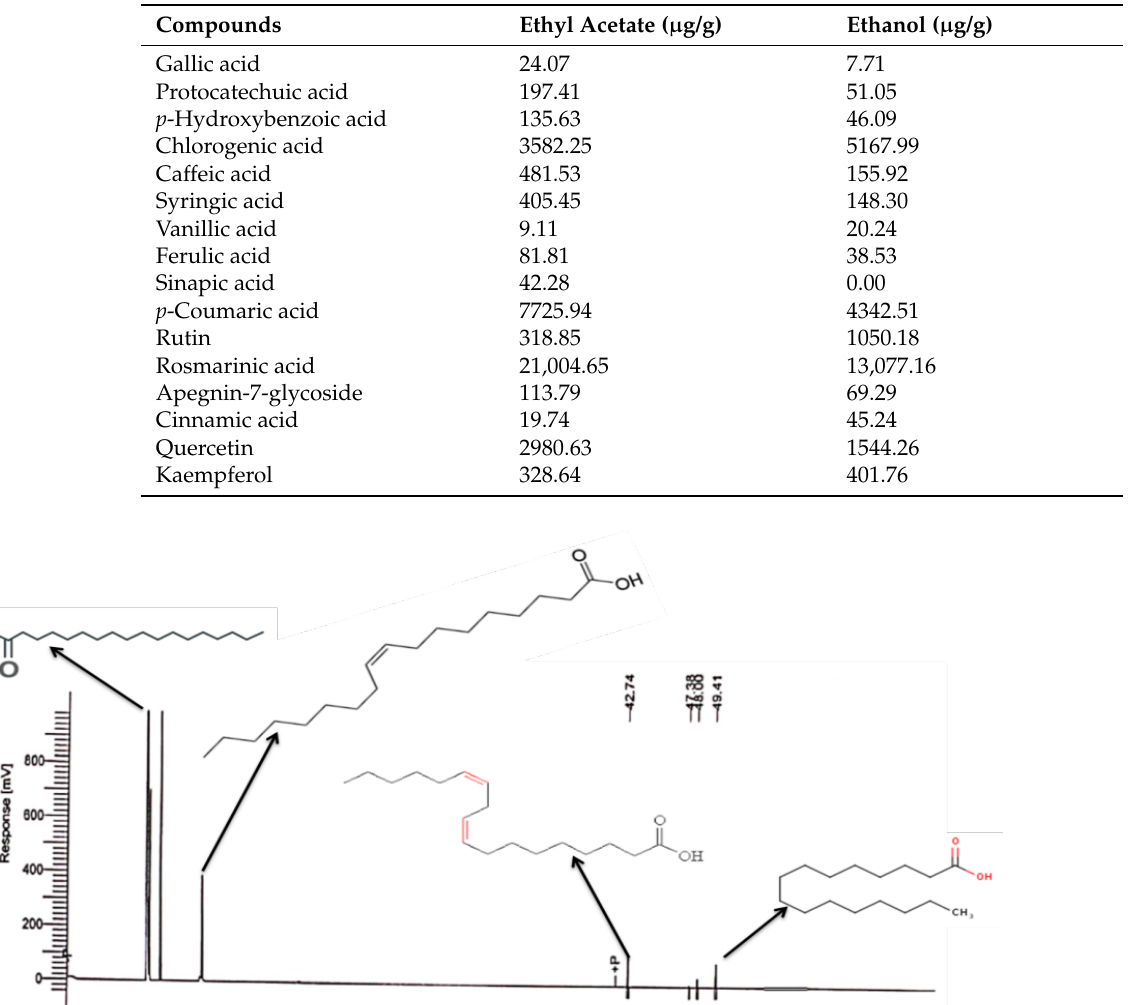
Table 2. Phenolic profile of Echinops spinosissimus ethyl acetate and ethanol extracts analyzed via HPLC.